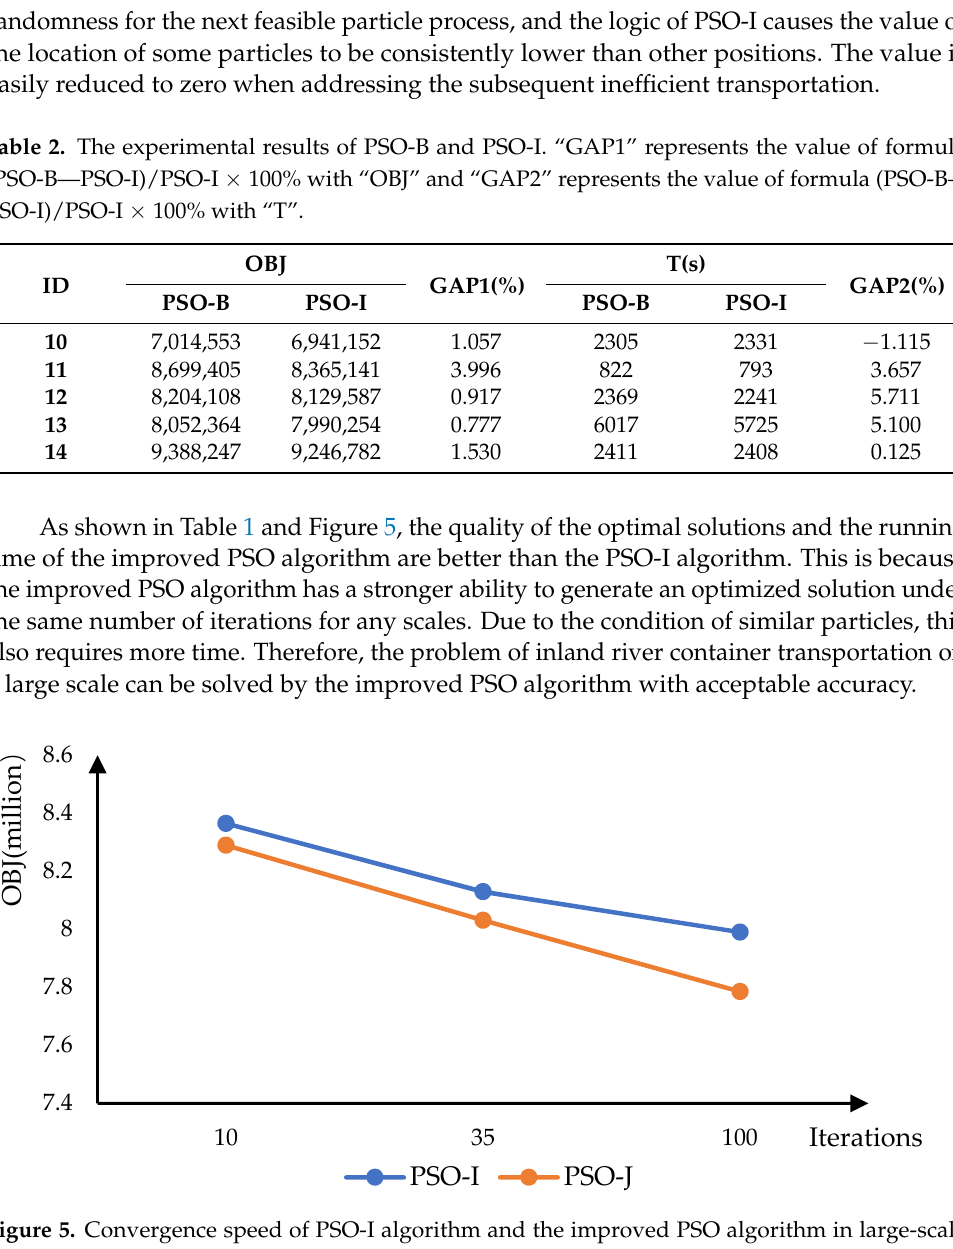
Figure 5. Convergence speed of PSO-I algorithm and the improved PSO algorithm in large-scale numerical experiments. With the increase of iteration times, the optimization effect of the improved PSO is better.